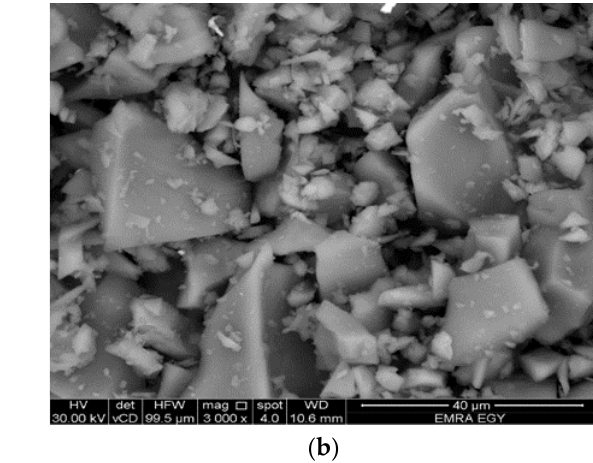
Table 2. Concrete mixture properties (in kg/m 3 ).